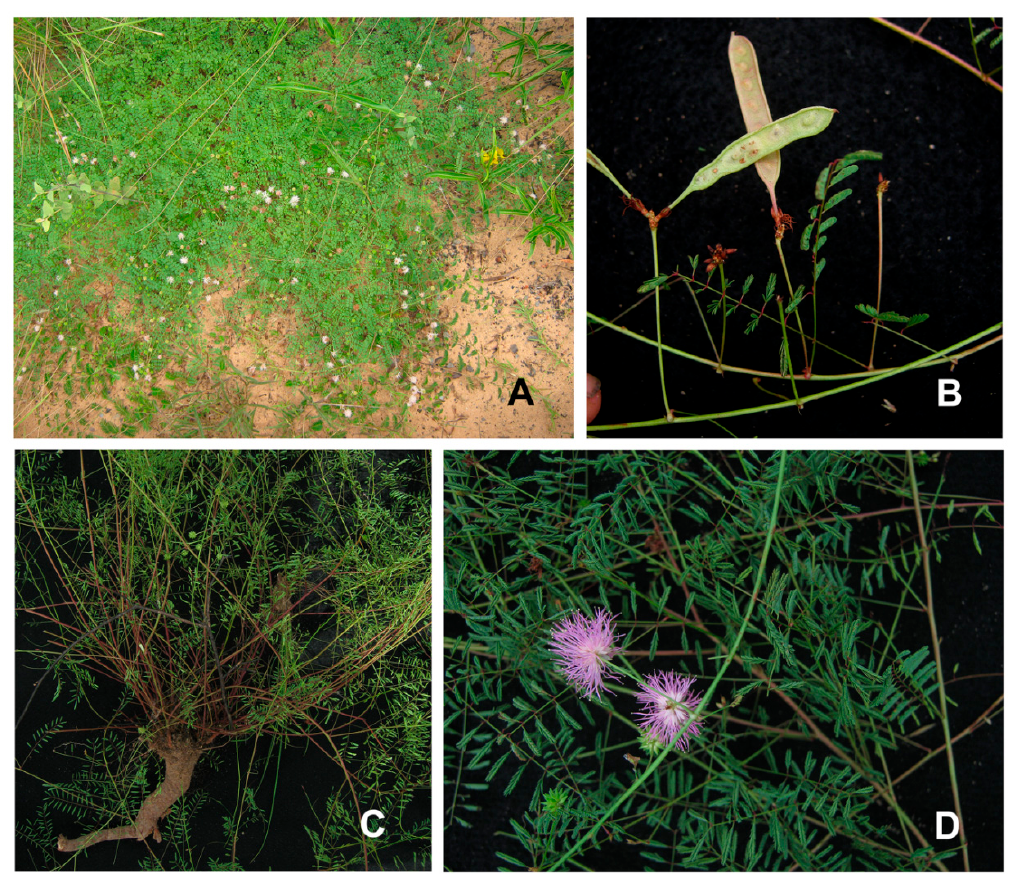
Figure 2. Mimosa carolina. ( A ). Prostate habit. ( B ). Immature fruits. ( C ). Base of plant with several slender branches arising from a wood xylopodium. ( D ). Inflorescence. Photos by Marcelo Simon.